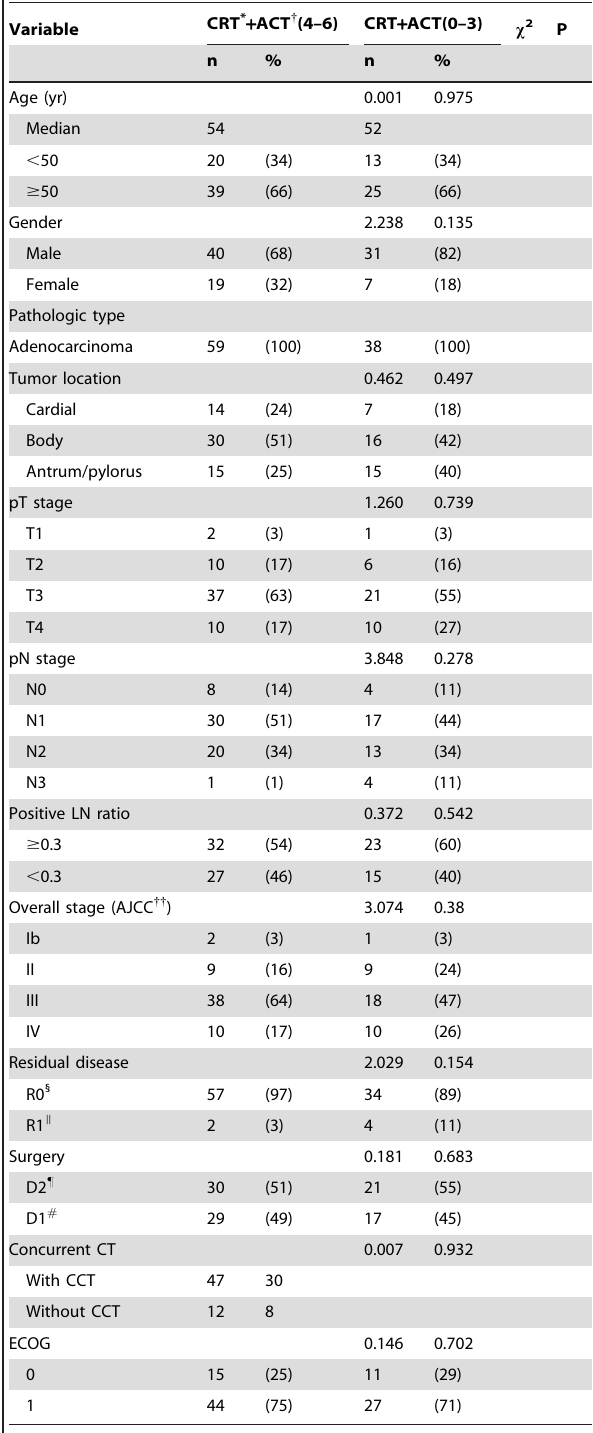
Table 1. Patient